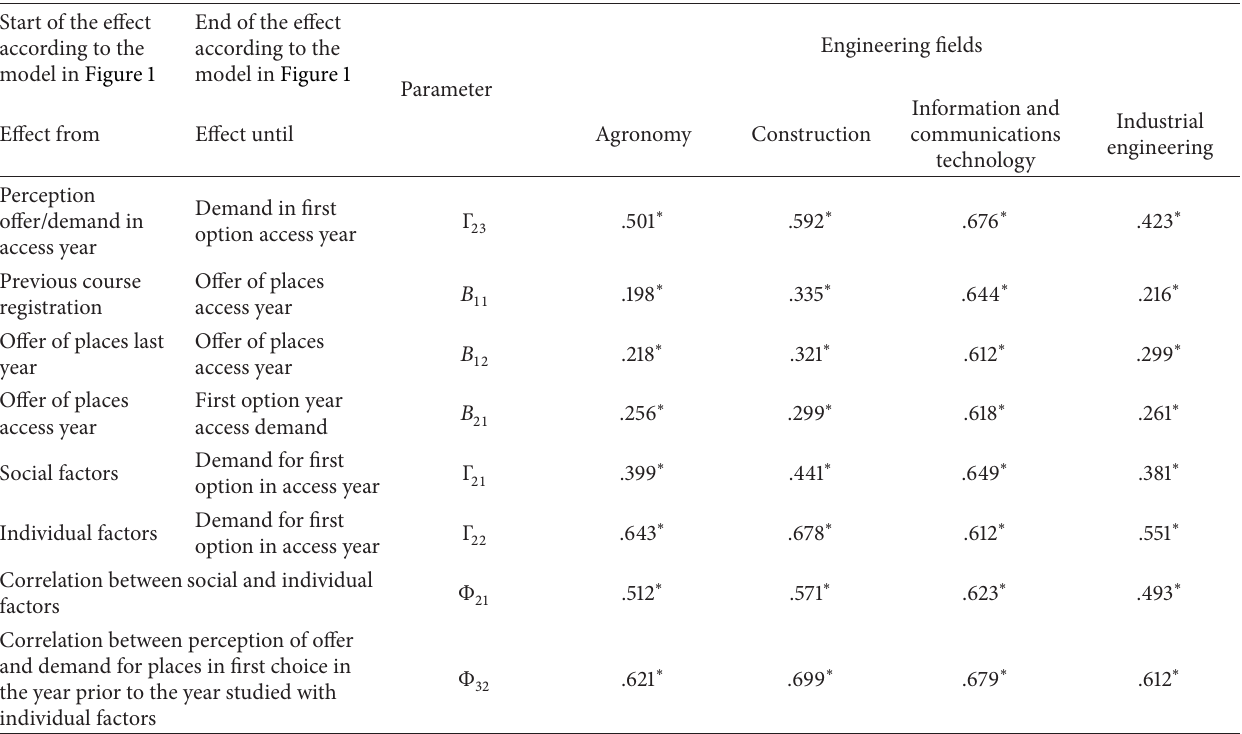
Table 5: Estimation of each standardized structural parameter for degrees at the